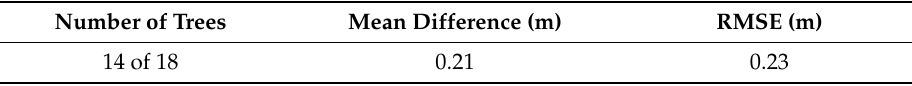
Table 4. Comparison of estimated tree positions and field reference